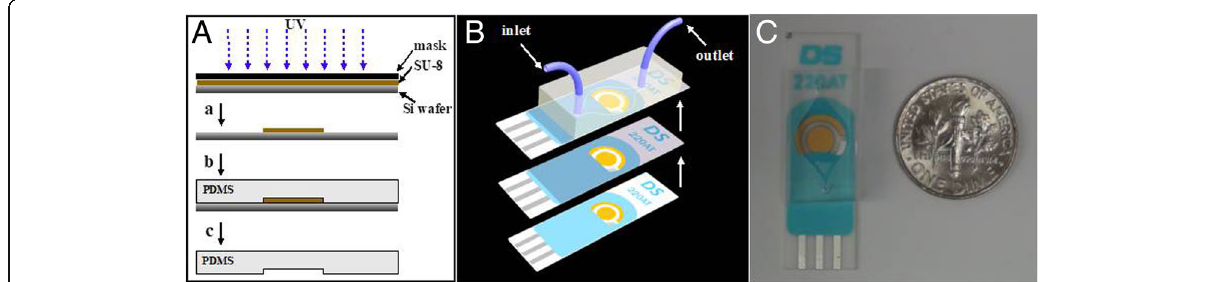
Fig. 1 a Fabrication process for the PDMS microfluidic channels patterned by SU-8 photolithography. b Fabrication process for the commercially available screen-printed electrode-based microfluidic device. The CASPE-MFD comprises PDMS microfluidic channels, two printed gold electrodes as the working and counter electrodes, and a printed silver electrode as the pseudo-reference electrode. c A commercially available screen-printed electrode-based microfluidic